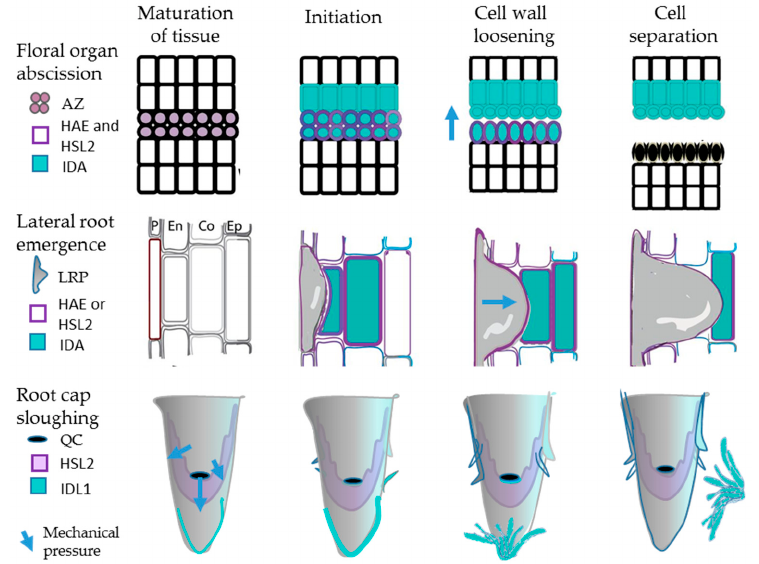
Figure 2. IDA / IDL and HAE / HSL2 involvement in floral organ abscission, lateral root emergence and root cap sloughing. These processes involve maturation of abscission zone (AZ) cells, cells overlying lateral root primordia (LRP), and lateral root cap (LRC) cells, respectively, and gradual cell wall loosening before the actual cell separation takes place. Mechanical pressure from expanded AZ cells in floral organ abscission, the LRP itself during emergence, and new LRC cells and elongating columella cells during root cap sloughing, is likely to contribute to these processes. QC—quiescent center. Another cell separation event found in the Arabidopsis root is sloughing of root cap cell layers that cover the root tip with the meristematic zone, the stem cell niche surrounding the Quiescent Centre (QC) and the gravity-sensing columella cells [27] (Figure 2). IDL1 is expressed in the cap, which